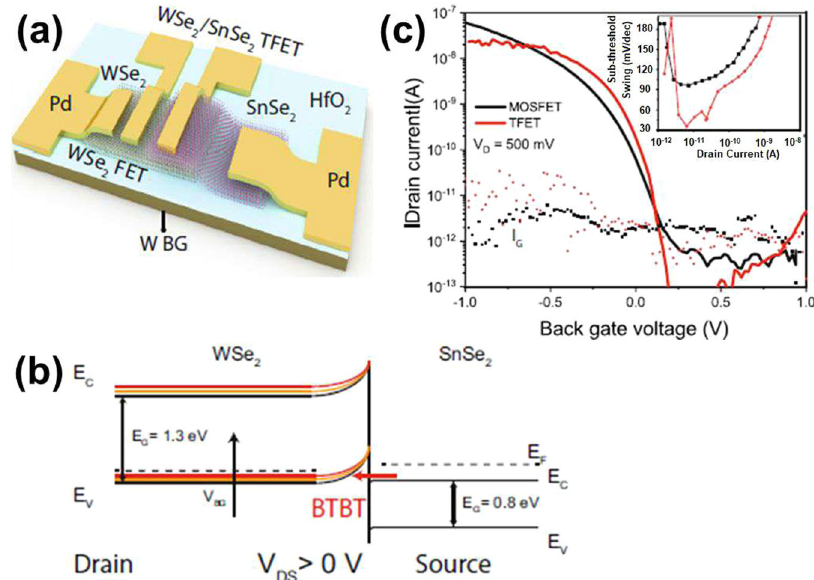
Fig. 27 Experimental Report on 2D vdW-TFET. a Device schematics, b equilibrium band alignments at the tunneling junction c comparative transfer characteristics and sub-threshold characteristics of WSe 2 /SnSe 2 , adapted with permission from 127 . Copyright (2020)